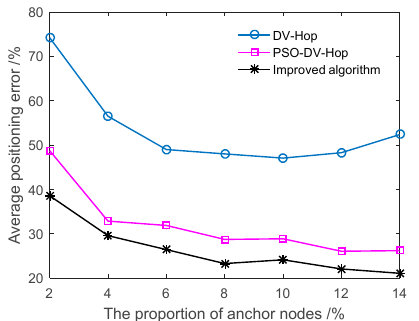
( b ) Figure 6. Comparison of average positioning errors of three algorithms for uniform distribution and random distribution: ( a ) average positioning error of uniform distribution of anchor nodes; ( b ) average positioning error under the random distribution of anchor nodes. It can be seen from Figure 6 that the proposed algorithm has a lower average positioning error than the PSO-DV-Hop algorithm and the DV-Hop algorithm when the anchor nodes are uniformly distributed or randomly distributed. The advantage is more obvious than the other two algorithms. With the increase in the number of nodes, the average positioning error obtained by the algorithm proposed in this paper shows an overall decreasing trend. Compared with the PSO-DV-Hop algorithm and DV-Hop algorithm, the volatility is less and the average positioning error obtained is more stable. When the anchor nodes are uniformly distributed, the average positioning error of all